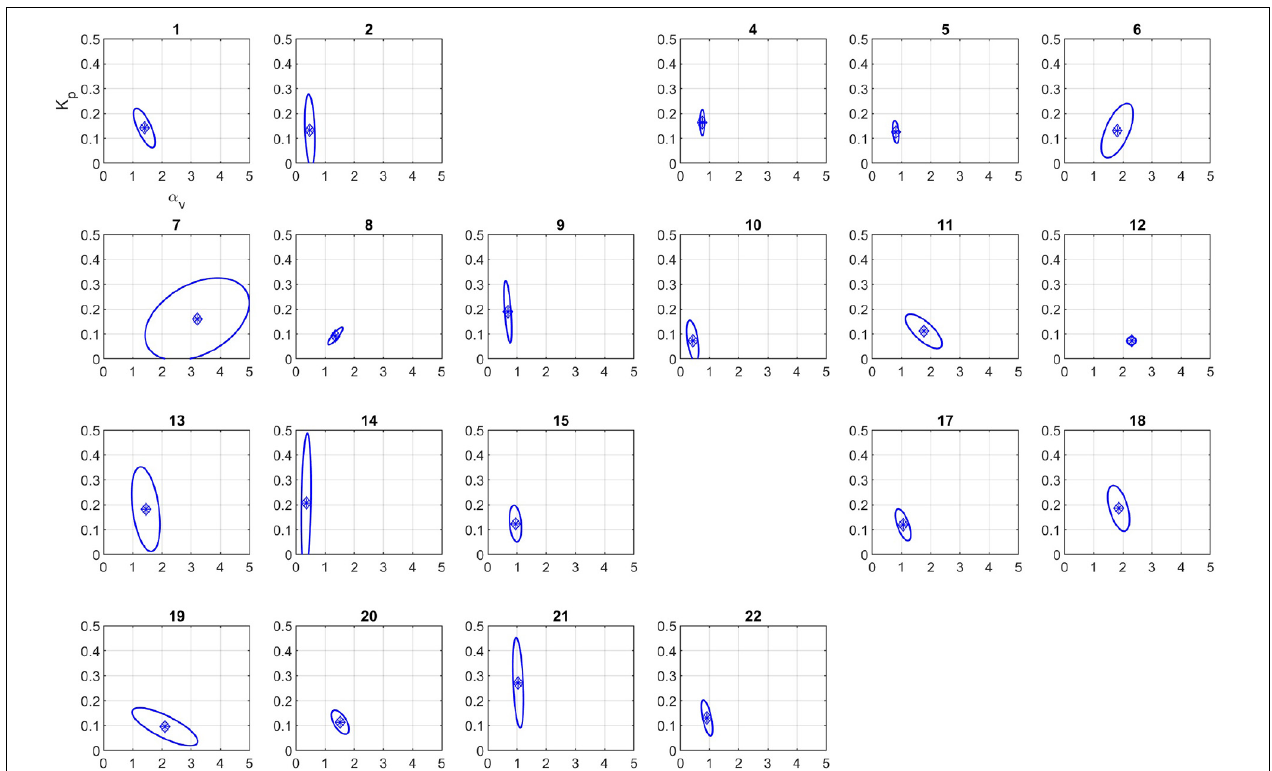
FIGURE 5 | 95% confidence regions for the calibrated parameters using the two parameter model. Subjects 3 and 16 were excluded because calibrated parameters were outside physiological range (see section “Discussion”).